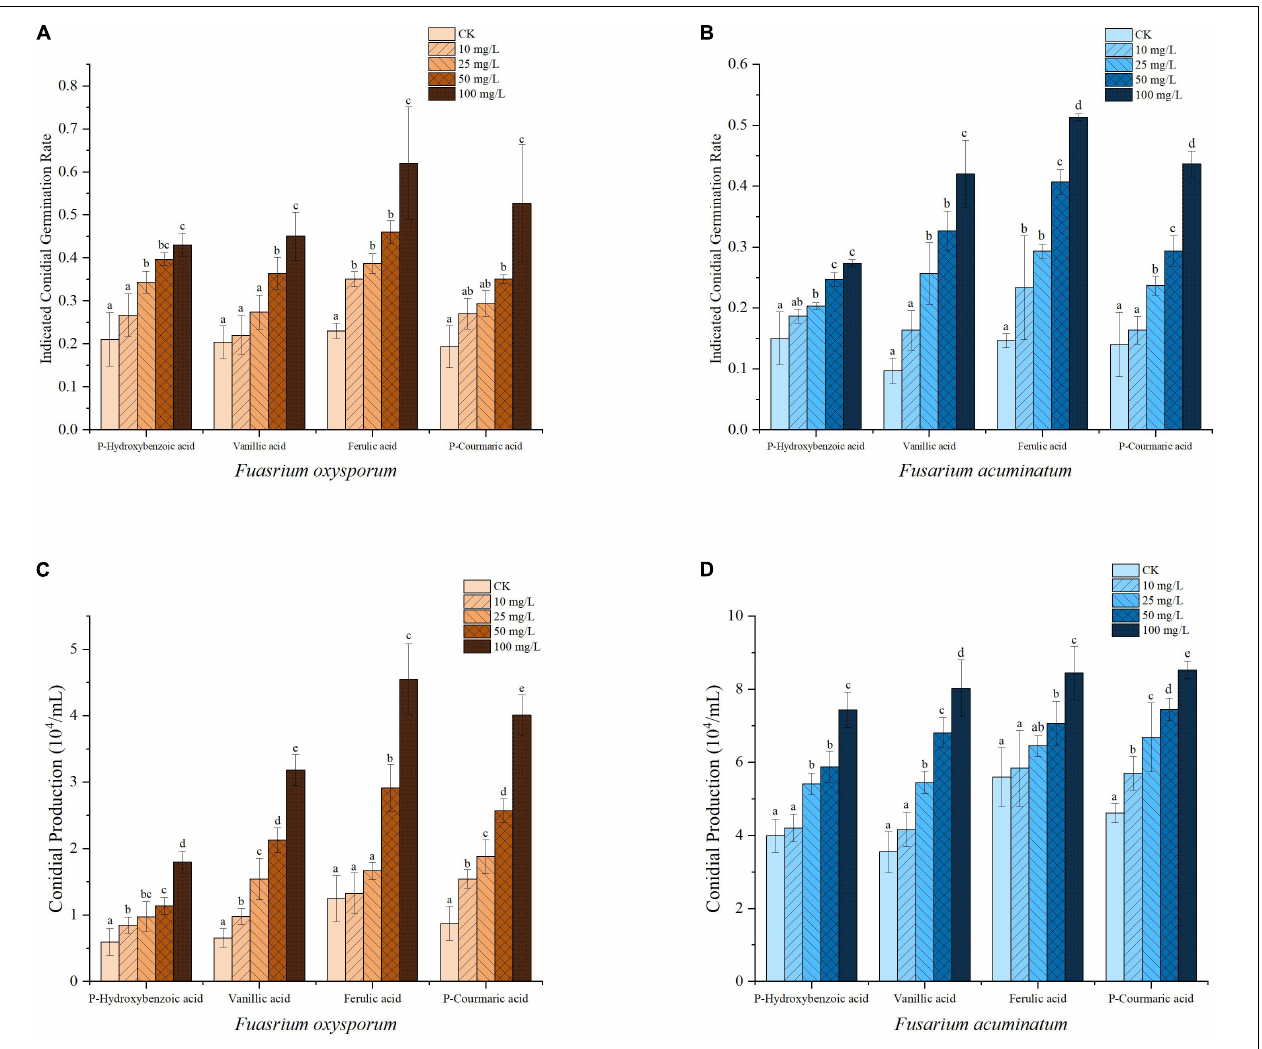
FIGURE 6 | Effects of phenolic acids on conidial germination and production of Fusarium oxysporum (A,C) and F. acuminatum (B,D) that cause alfalfa root rot. Different letters above the bars indicate significant difference according to Duncan’s multiple range test ( P =